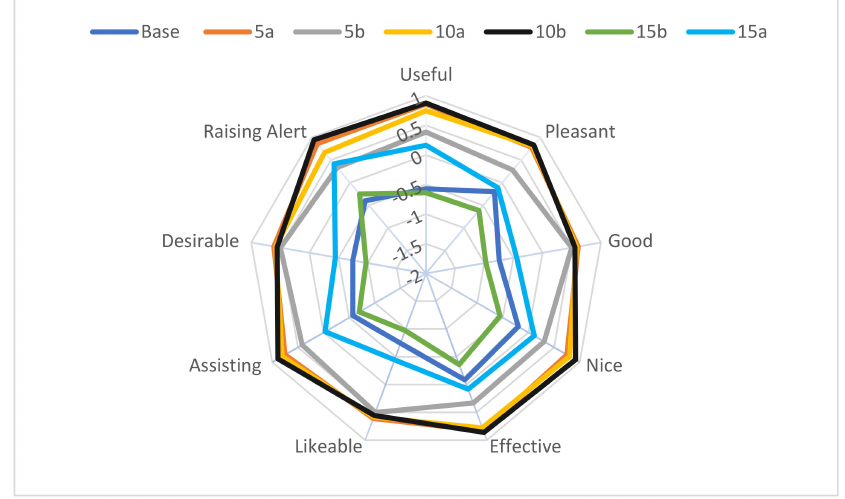
Figure 7. Van der Lann Acceptance score for an ego vehicle driver.